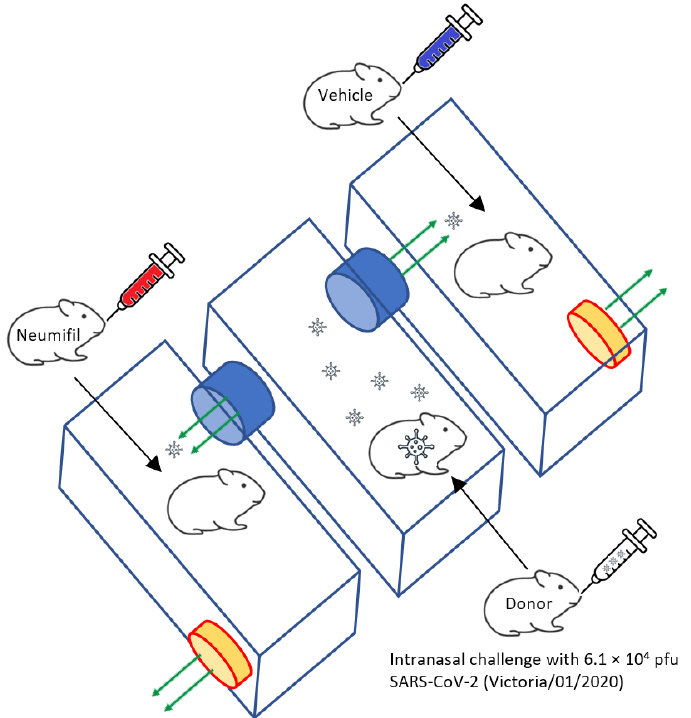
Figure 1. Diagrammatic representation of natural transmission cage layout. Donor animals were challenged with SARS-CoV-2 and placed in the centre cage, with recipient animals receiving Neumifil or vehicle housed in adjacent cages. Fans on the side of the outer two cages allowed airflow to flow across from the centre